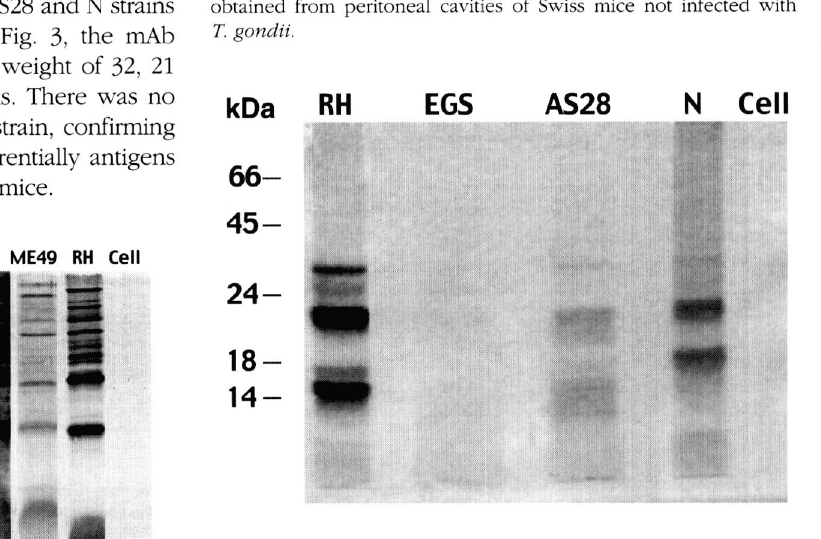
Fig. 1 - Western blotting analysis of antigens of P, C4, SAF, EGS, AS28, BV, N, ME49 and RH strains of Toxoplasma gondii reacted with rabbit antiserum to T. gondii. Equal numbers (10 4 ) of purified tachyzoites from each strain were subjected to 12,5 % polyacryla- mide gel and electrophoretically transferred to nitrocellulose mem­ brane. Molecular weight markers (in kilodaltons) are indicated on the left. Cell - cells obtained from peritoneal cavities of Swiss mice not infected with T. gondii.